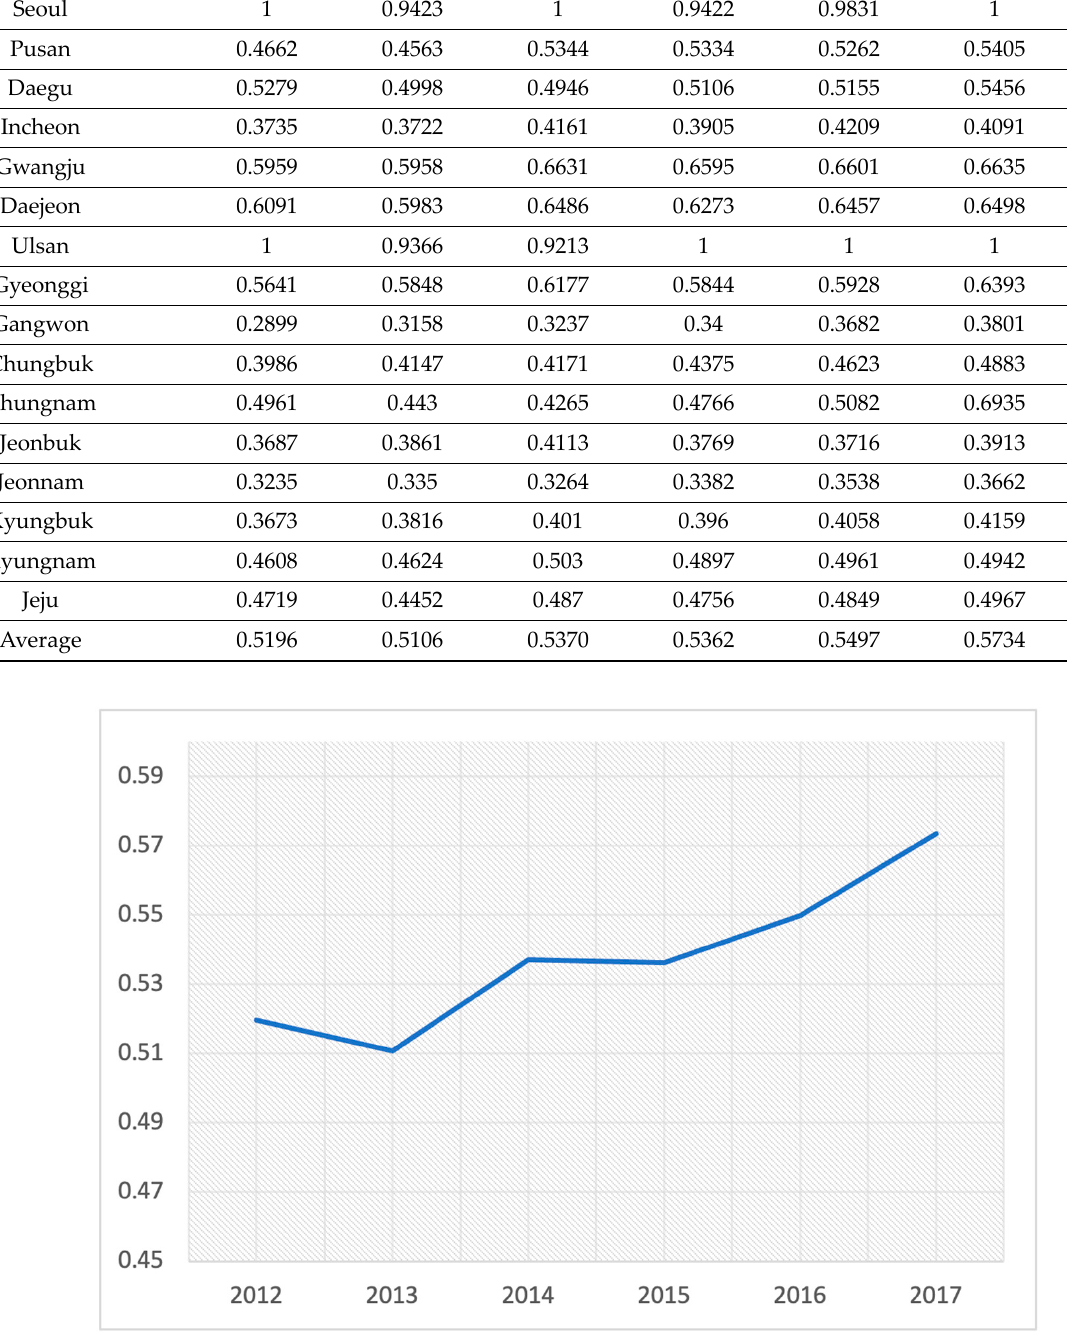
Figure 4. National PM2.5 efficiency’s trend, 2012–2017.